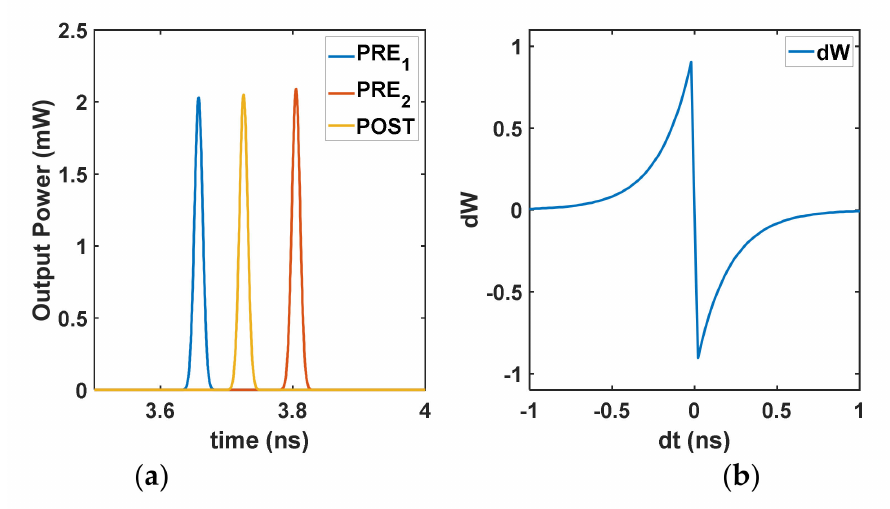
Figure 6. ( a ) Timing of spikes originating from the neuron under training (POST) and two other presynaptic neurons (blue and red). ( b ) The spike dependent plasticity (STDP) weight modification curve. According to STDP, training w 1 will be increased while w 2 will be